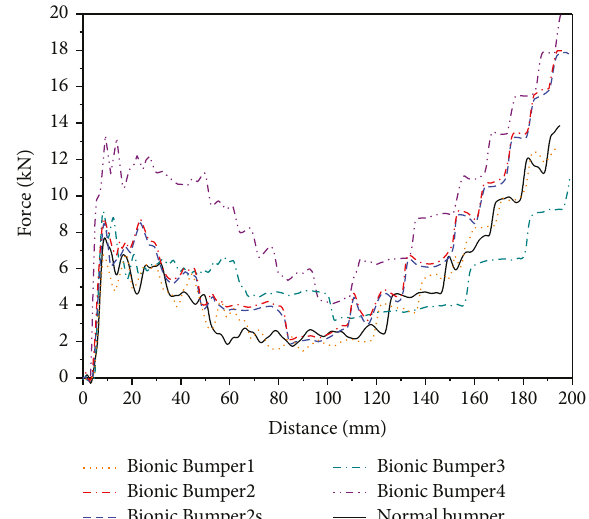
Figure 15: The force curve vs displacement for fi ve bumpers.